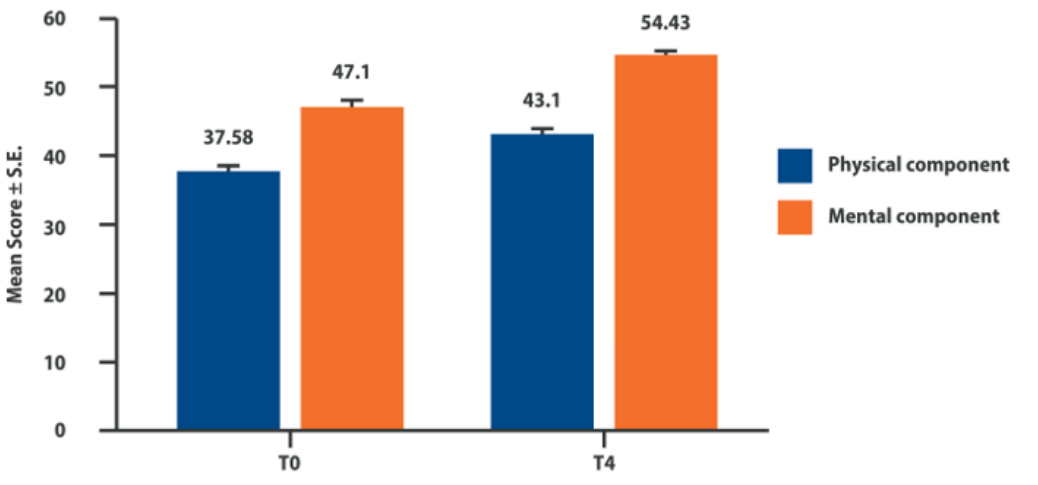
Figure 3. Changes in the SF12. Adapted from [73].